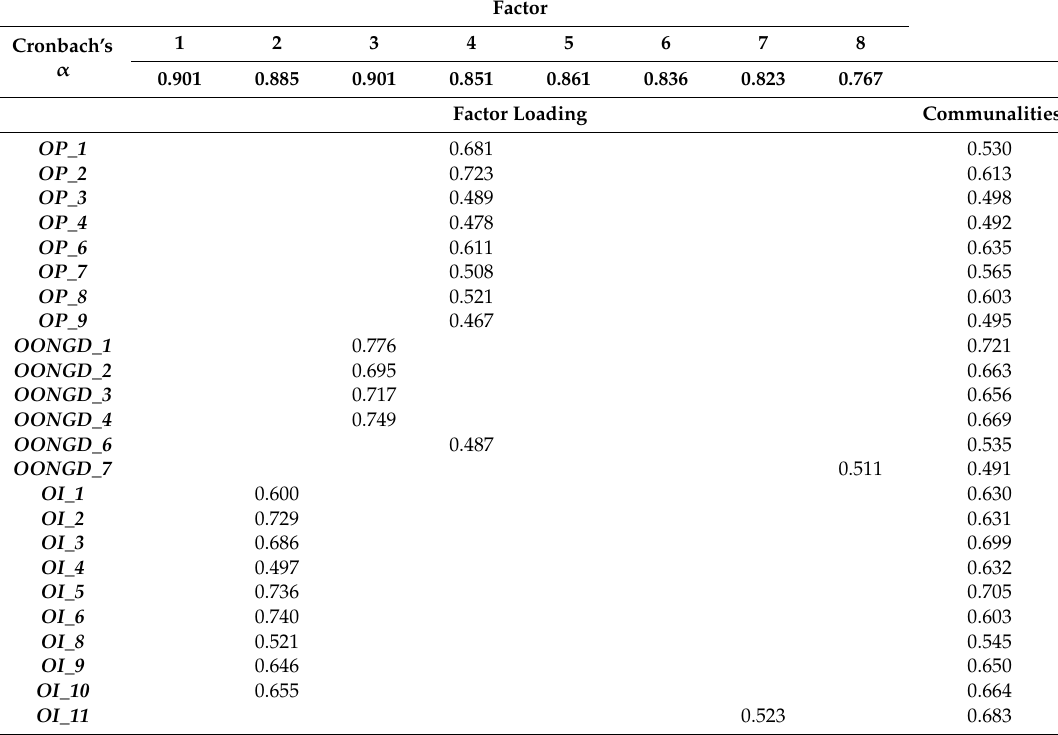
Table A4. Results of the exploratory factor